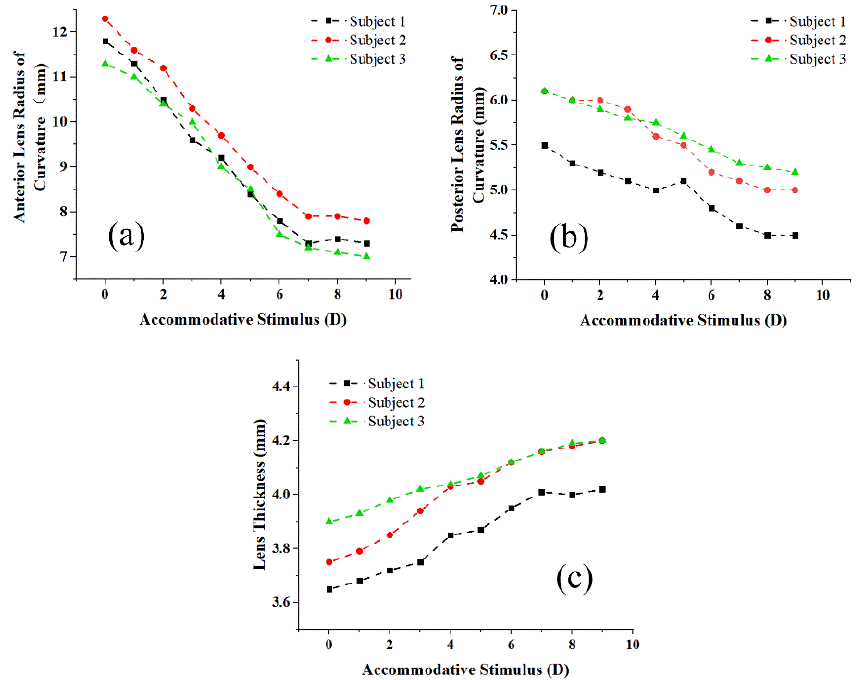
Figure 8. The change of lens geometric parameters during accommodation in 3 subjects: ( a ) anterior lens curvature radius; ( b ) posterior lens curvature radius; ( c ) lens thickness.